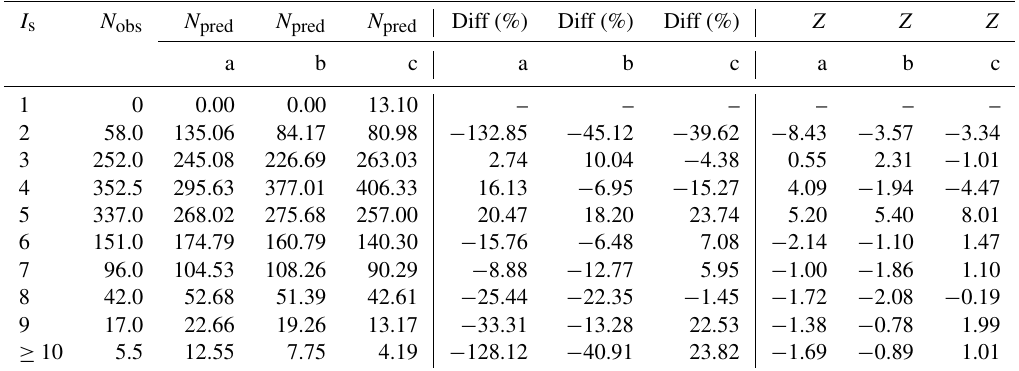
Table 3. Observed ( N obs ) and predicted ( N pred ) number of intensity values for each analysis (a, b, c) with their differences as a percentage (Diff) and the results of the Z test ( Z ).